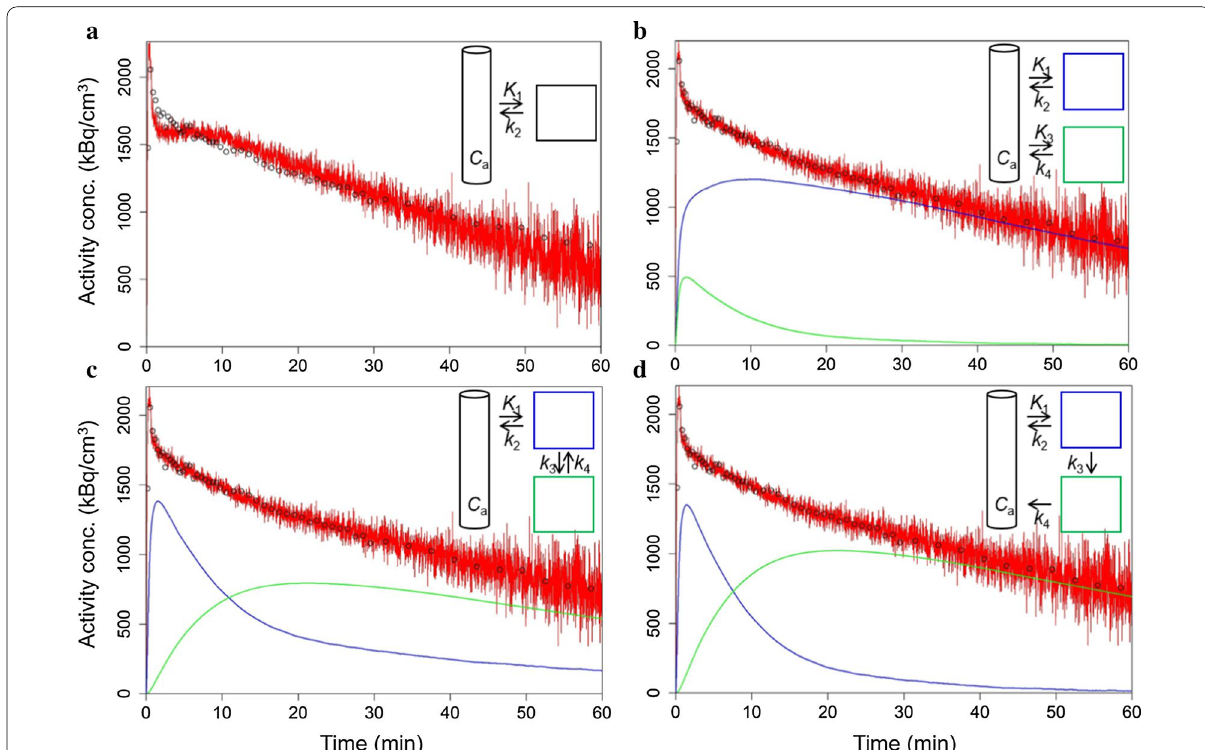
Fig. 6 Representative TAC (black symbols) and fits (red lines) to a one-tissue compartment model (TCM1, a ) and three two-tissue compartment models, b TCM2p, c TCM2s, d TCM2v. Tracer activity concentrations were simulated for the individual compartments as indicated in the insets (green and blue lines). The volume-of-interest corresponded to 0.5% of the individual body volume